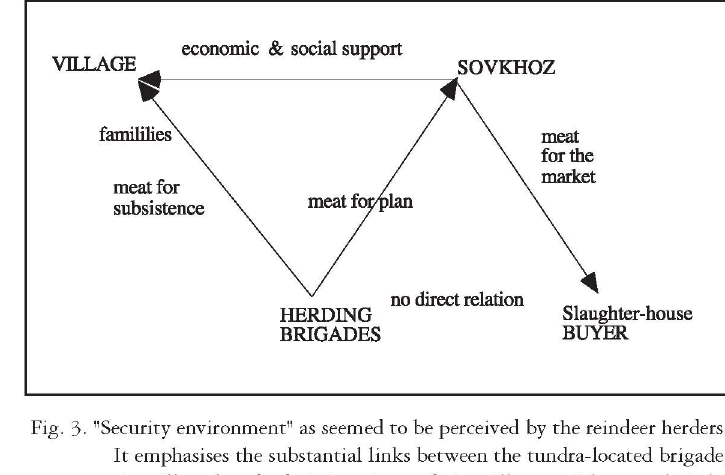
Fig. 3. "Security environment" as seemed to be perceived by the reindeer